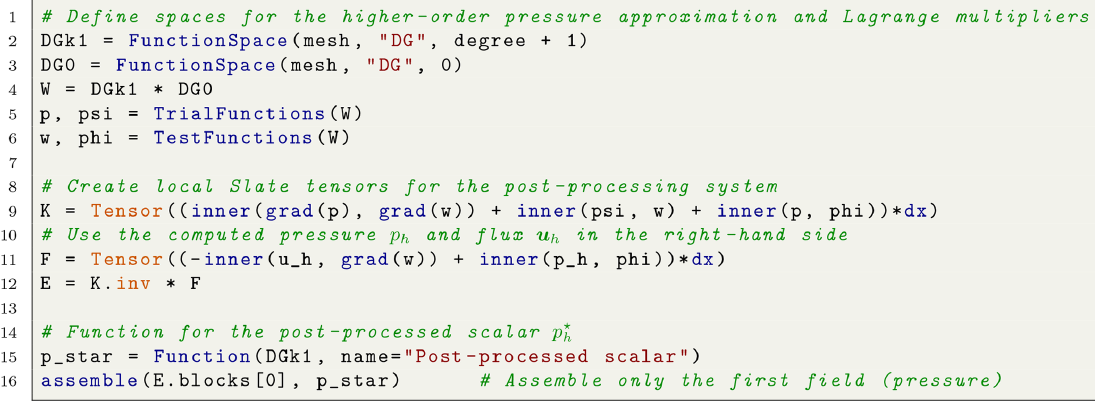
Figure 3. Example of local post-processing using Firedrake and Slate. Here, we locally solve the mixed system defined in Eqs. (58)–(59). The corresponding symbolic local tensors are defined in lines 9 and 11. The Slate expression for directly inverting the local system is written in line 12. In line 16, a Slate-generated kernel is produced which solves the resulting linear system in each cell. Since we are not interested in the multiplier, we only return the block corresponding to the new pressure